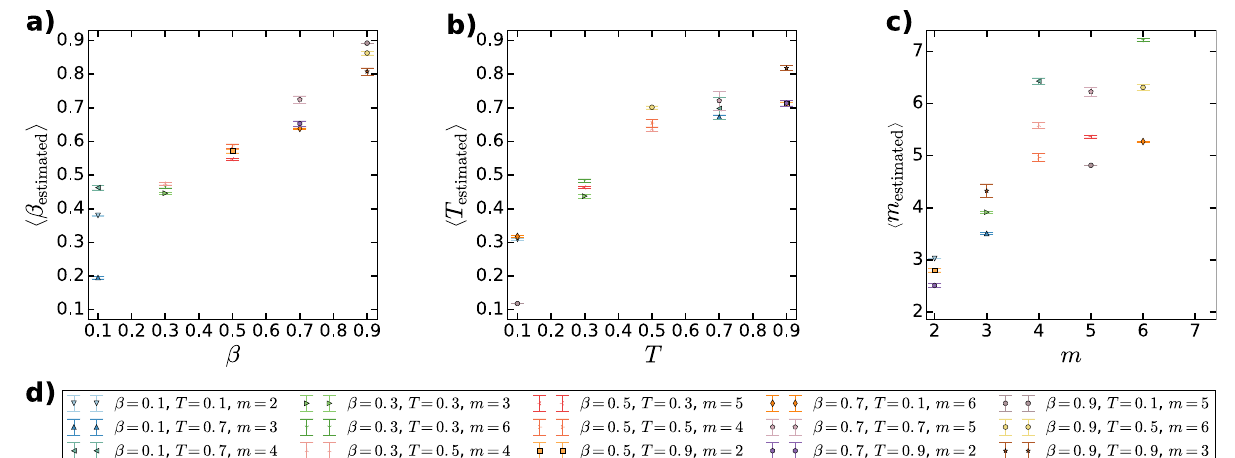
Figure 3. Estimated parameters in synthetic networks generated by the PSO model. We show the estimated values as a function of the true value used during the network generation process, averaged over 100 samples for the m parameter in panel ( a ), the β parameter in panel ( b ), and the T parameter in panel ( c ). The colours indicate the different parameter combinations listed in panel ( d ). The bars indicate the 95% confidence